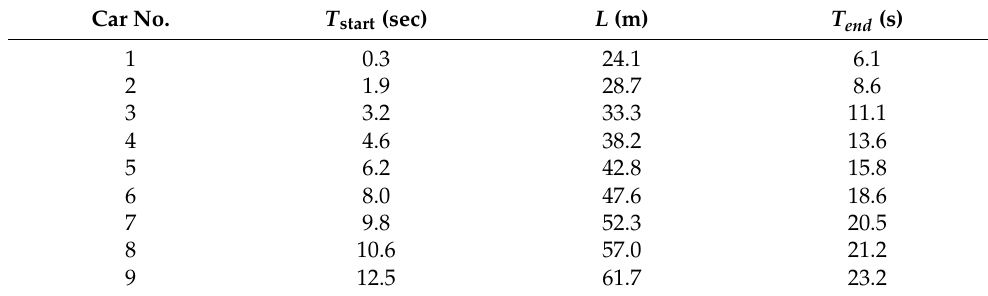
Table 1. Car parameters at the